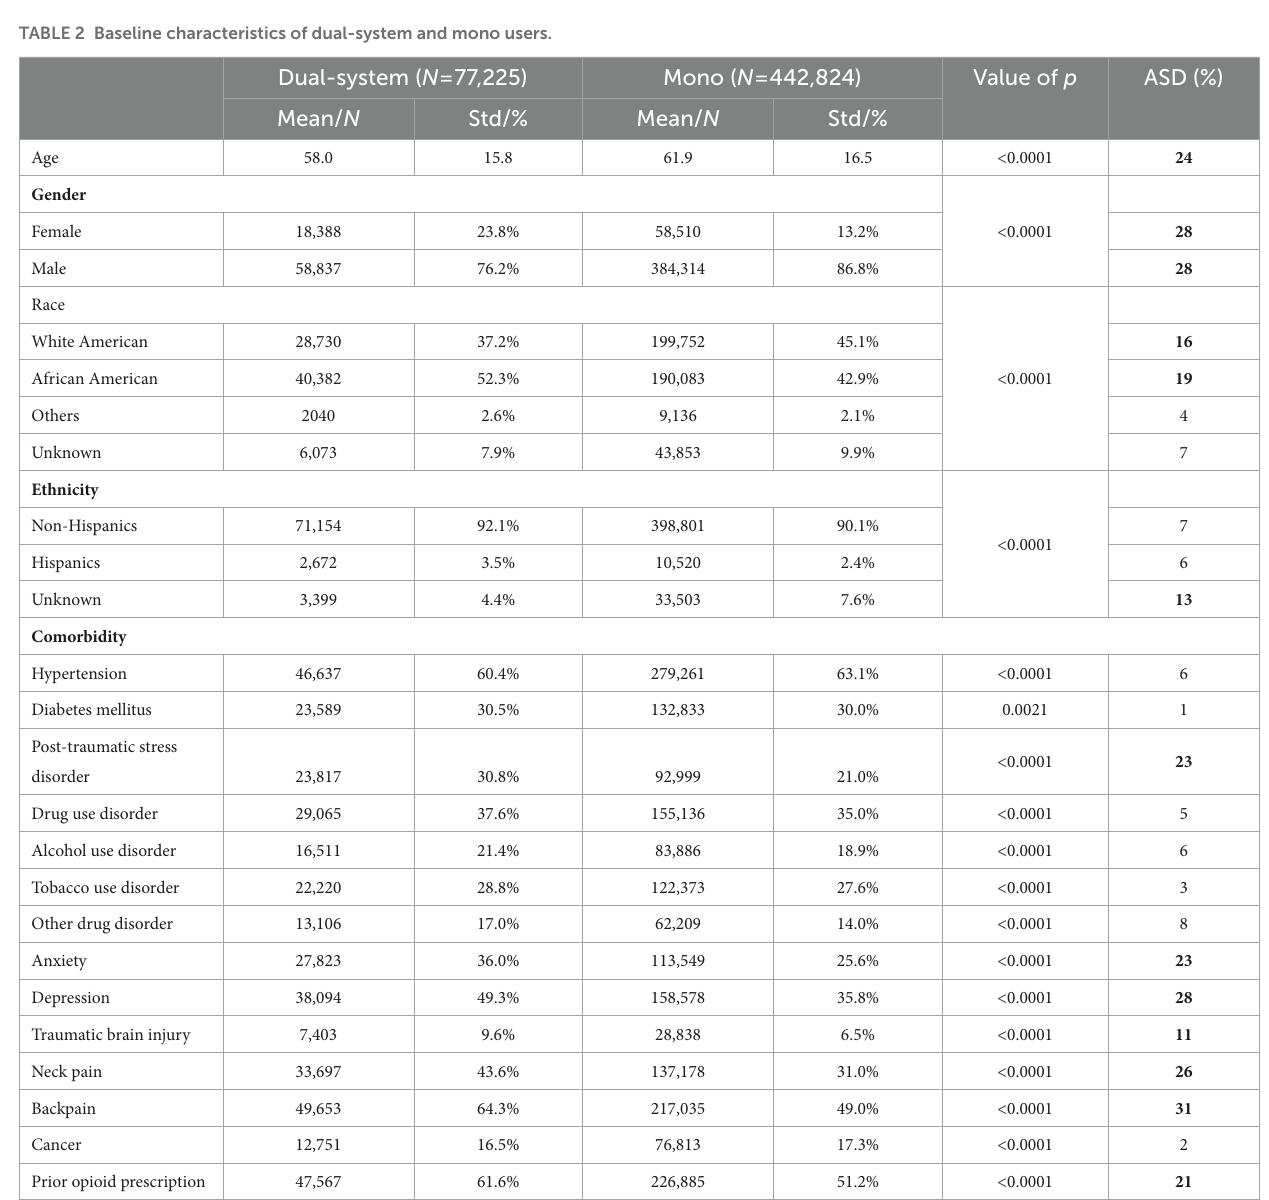
TABLE 2 Baseline characteristics of dual-system and mono